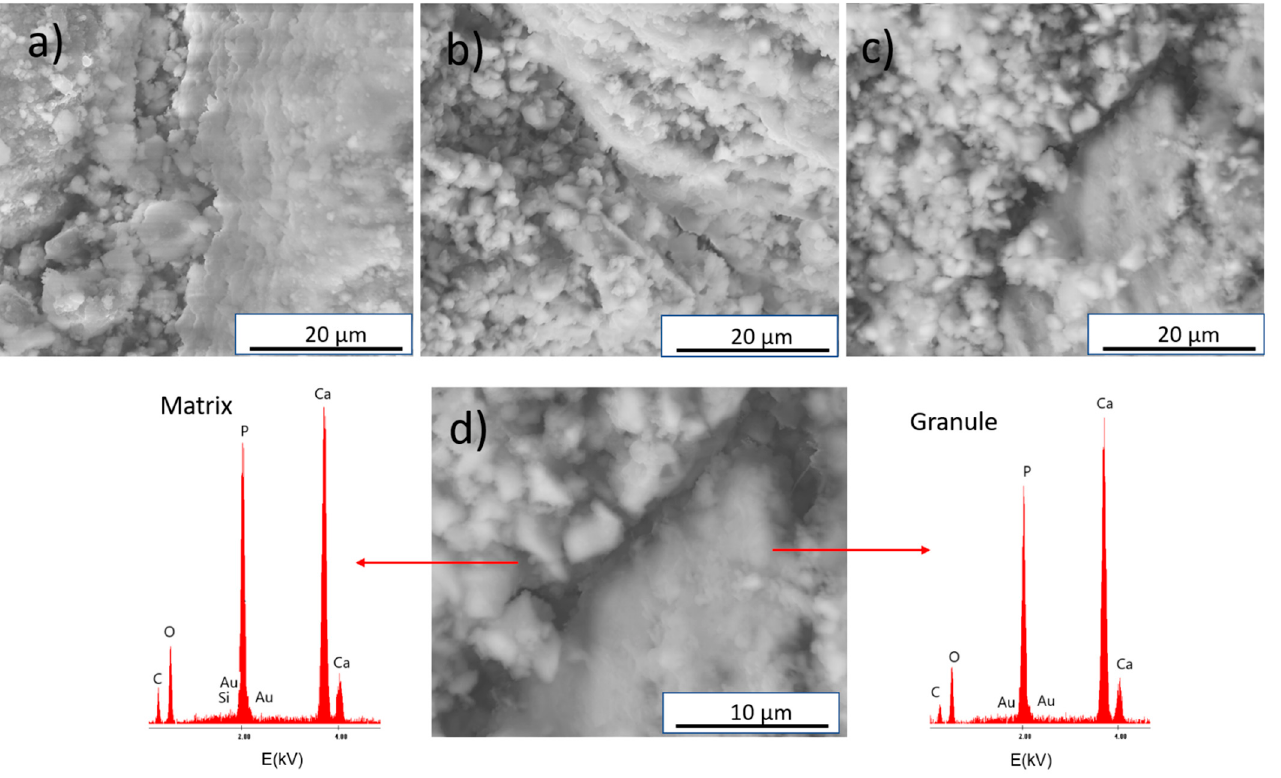
Figure 3. SEM microphotographs of the cross-sections of materials: ( a ) HT, ( b ) Au-HT, ( c ) Au, Si-HT, and ( d ) results of EDS analysis of Au, Si-HT.